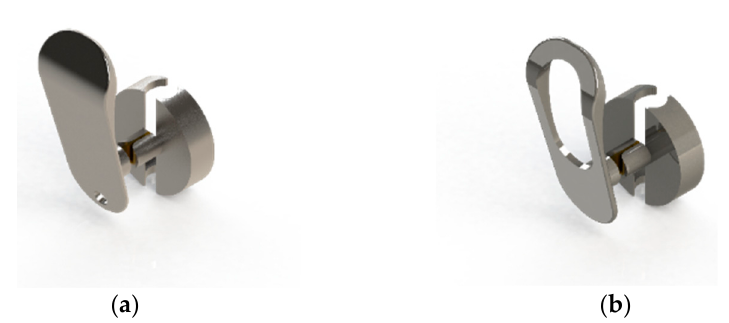
Figure 3. Three-dimensional visualization of the ADOD-V2 system with a vertical leaf: ( a ) without opening; ( b ) with opening.